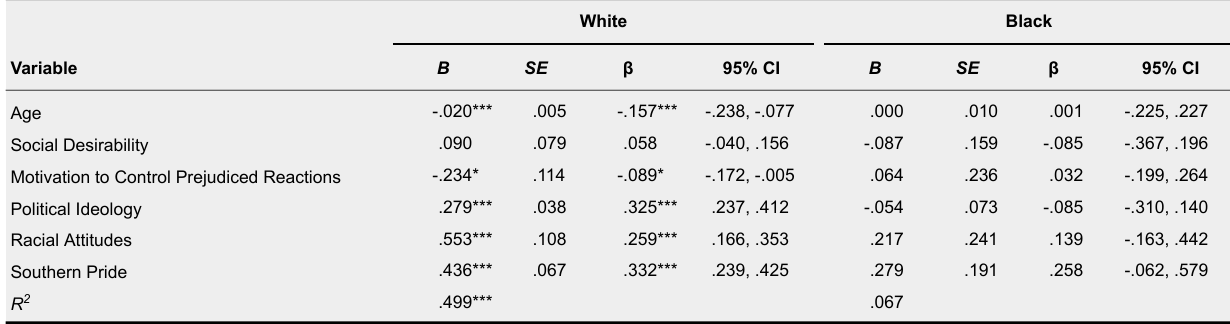
Summary of Structural Equation Model Predicting Attitudes Toward the Confederate Battle Flag (N =